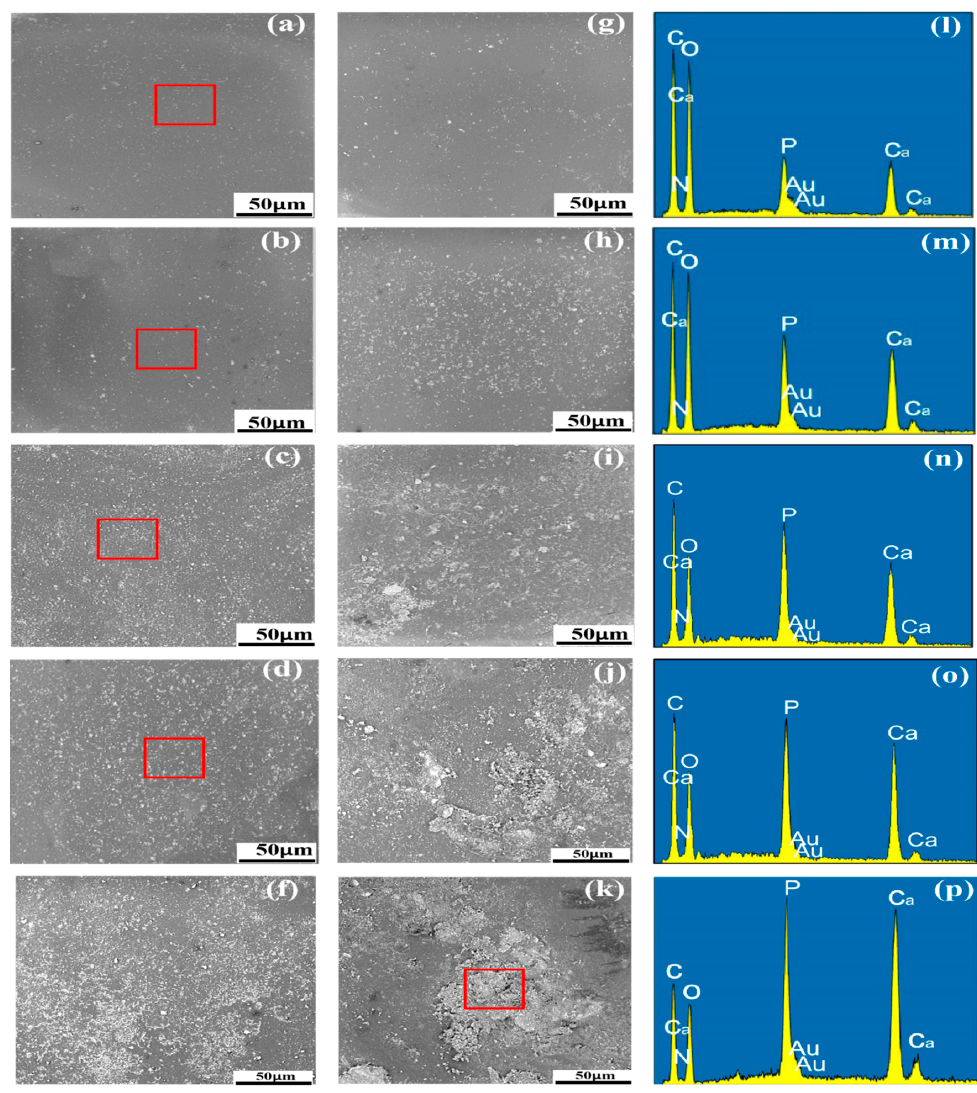
Figure 3. The distribution of C-HAP and HAP nanoparticles in the PLLA matrix with different filler content ( a ) 5% C-HAP, ( b ) 10% C-HAP, ( c ) 15% C-HAP, ( d ) 20% C-HAP, ( e ) 25% C-HAP, ( f ) 5% HAP, ( g ) 10% HAP, ( h ) 15% HAP, ( j ) 20% HAP, (k) 25% HAP; ( l – p ) EDS mapping of corresponding square